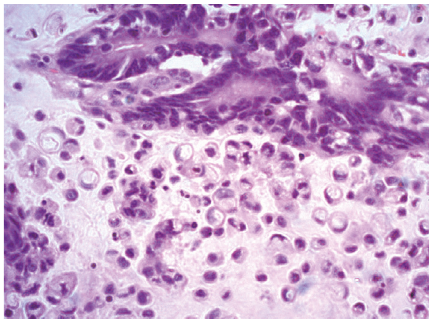
Figure 2: Immunohistochemical analysis with Cytokeratin 7 under × 40 showing focal cytoplasmic